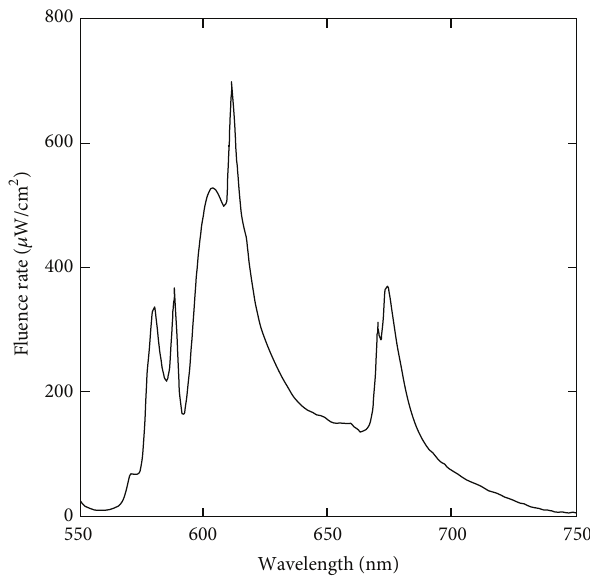
Figure 1: Spectral output from metal-halide lamp